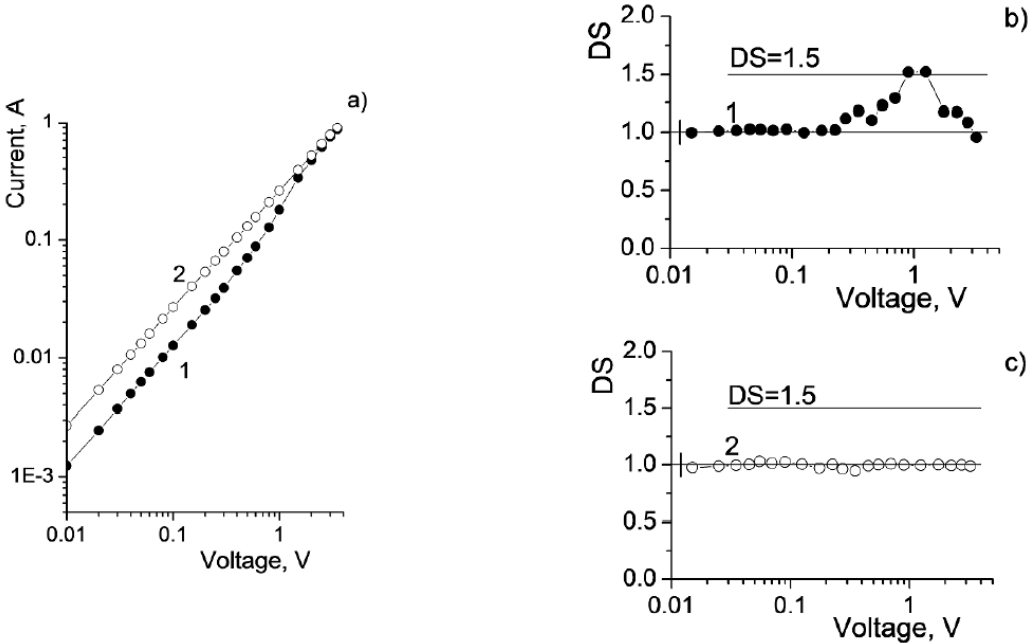
Figure 6. ( a ) Current–voltage characteristics (CVCs) of 10 min deposited sulfacyl sodium on carbon substrate 1 in the dark and under illumination; ( b , c ) dimensionless sensitivities (DS) of CVCs.